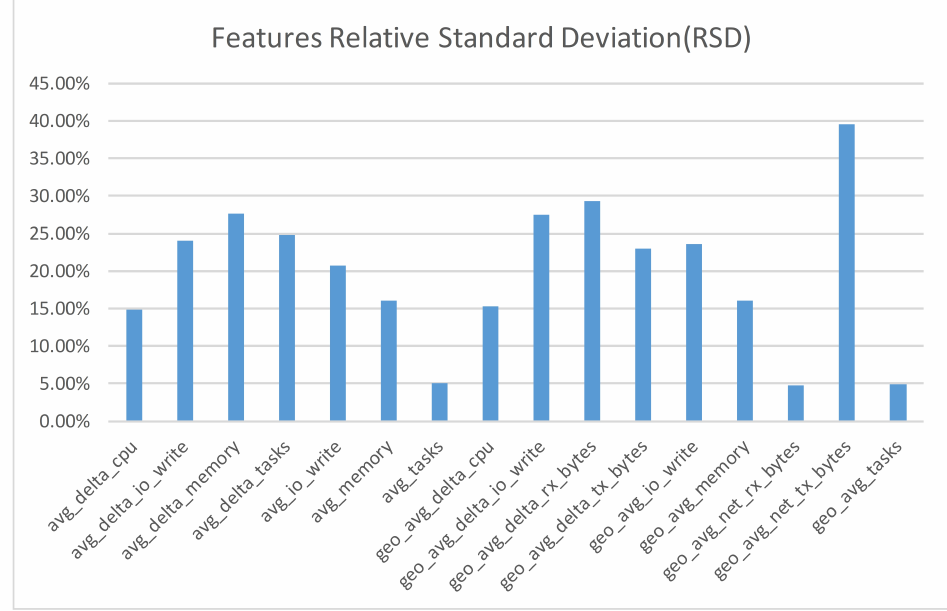
Figure 4. Profile features relative standard deviation.